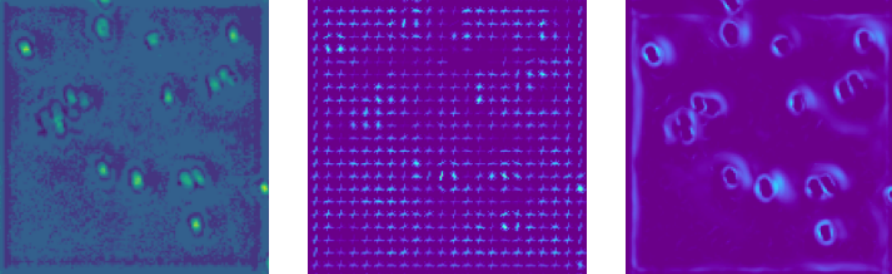
Figure 2. ( Left ) A cropped section of an image without processing. ( Middle ) The same cropped image section after applying the HOG processing. ( Right ) The same cropped image section after applying the Frangi